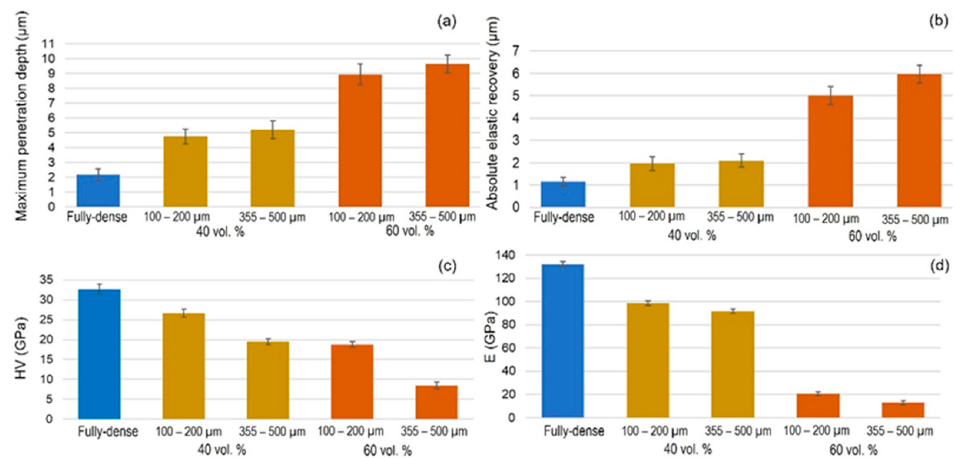
Figure 7. Static loading–unloading test ( P–h curves) parameters of the different FSL modified substrates studied: ( a ) maximum penetration depth; ( b ) absolute elastic recovery; ( c ) micro-hardness ( HV ); and ( d ) Young’s modulus ( E ). Note: c and d are calculated following the Oliver and Pharr method.